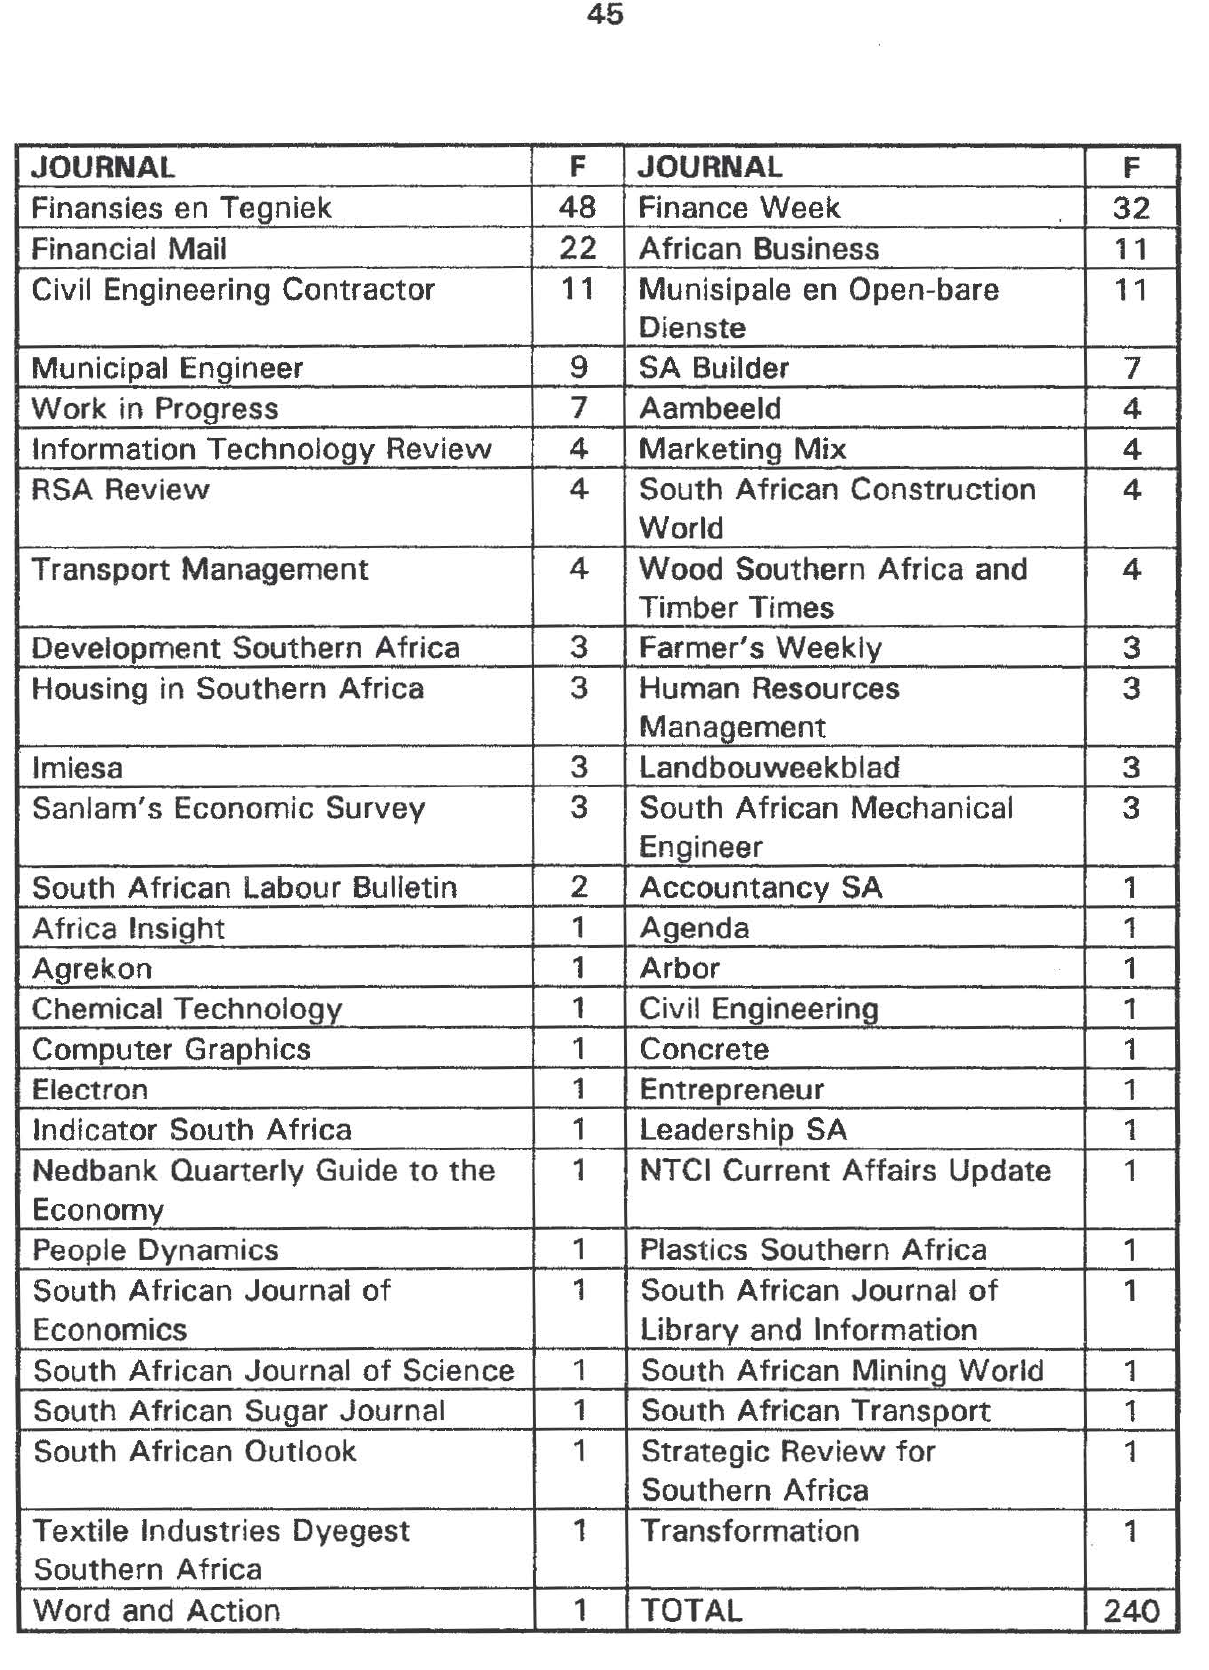
Table 1: Frequency of articles in journals referring to the RDP during